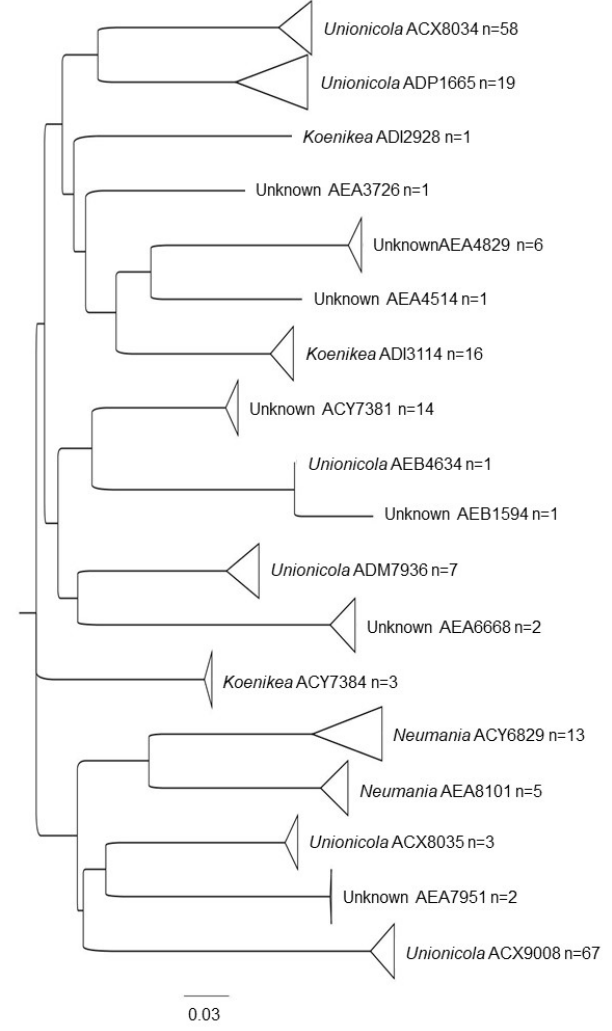
Figure 4. Neighbor Joining (NJ) tree for Unionicolidae family.